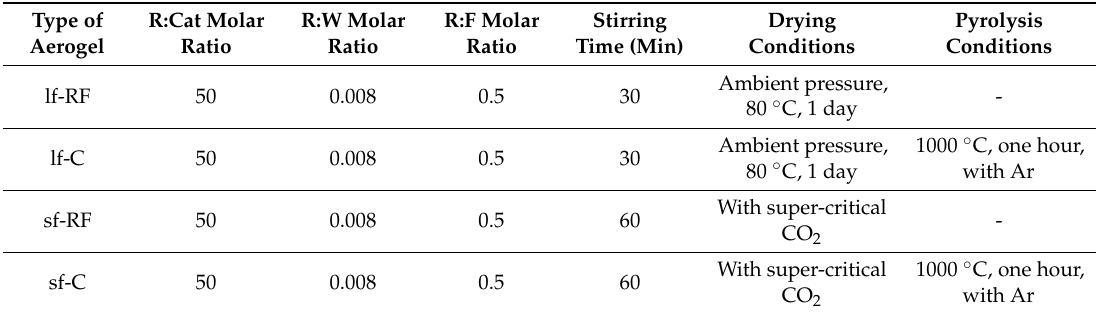
Table 3. Synthesis parameters of low-flexible and super-flexible resorcinol-formaldehyde and carbon